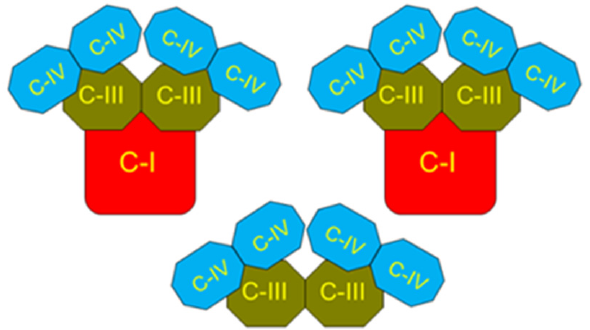
Figure 3. Schematic presentation of the mitochondrial respirasome structure. The figure is based on the data presented in refs [66,67].